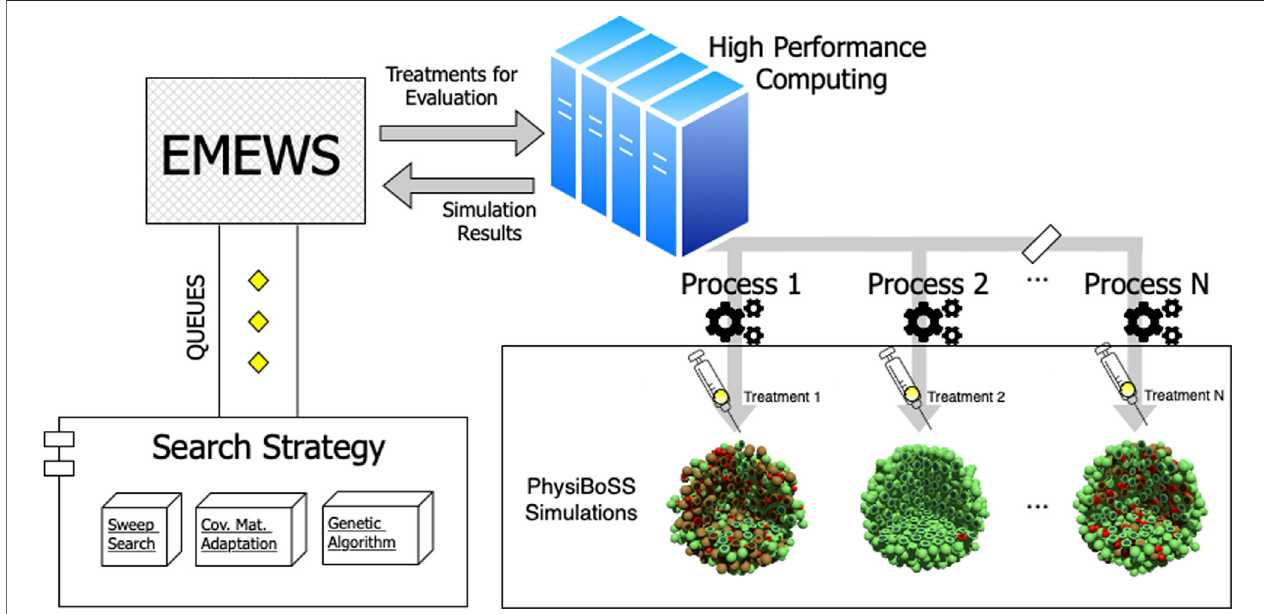
FIGURE 2 | Work fl ow overview. The diagram depicts the structure of the model exploration work fl ow. EMEWS communicates to the different search strategies using a queue system. The search strategy generates candidate parameters, and the treatments to be evaluated via PhysiBoSS simulations are distributed as parallel jobs to the HPC infrastructure. Upon completion, the simulation outcomes are returned to EMEWS, which, in the case of the GA and CMA-ES, sends the fi tness of the evaluated parameters, so the algorithm can update its internal state and generate new candidate